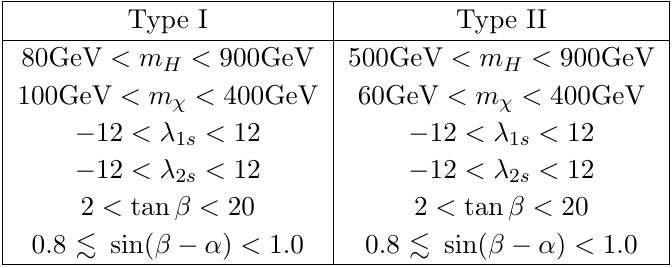
Table 1 . The range of scan for relevant parameters for Type I and Type II 2HDM.